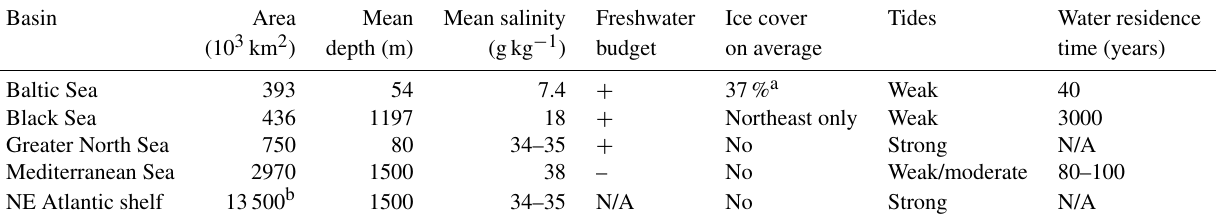
Table 5. Main characteristics of physical features of European seas (Leppäranta and Myrberg, 2009; Sündermann and Pohlmann, 2011; http://www.ospar.org, last access: 8 February 2022; British Oceanographic Data Centre). The greater North Sea – being the neighbouring sea area to the Baltic Sea – is a subregion of the NE Atlantic, but other European subregions are not listed (from Myrberg et al., 2019). Note: N/A is not